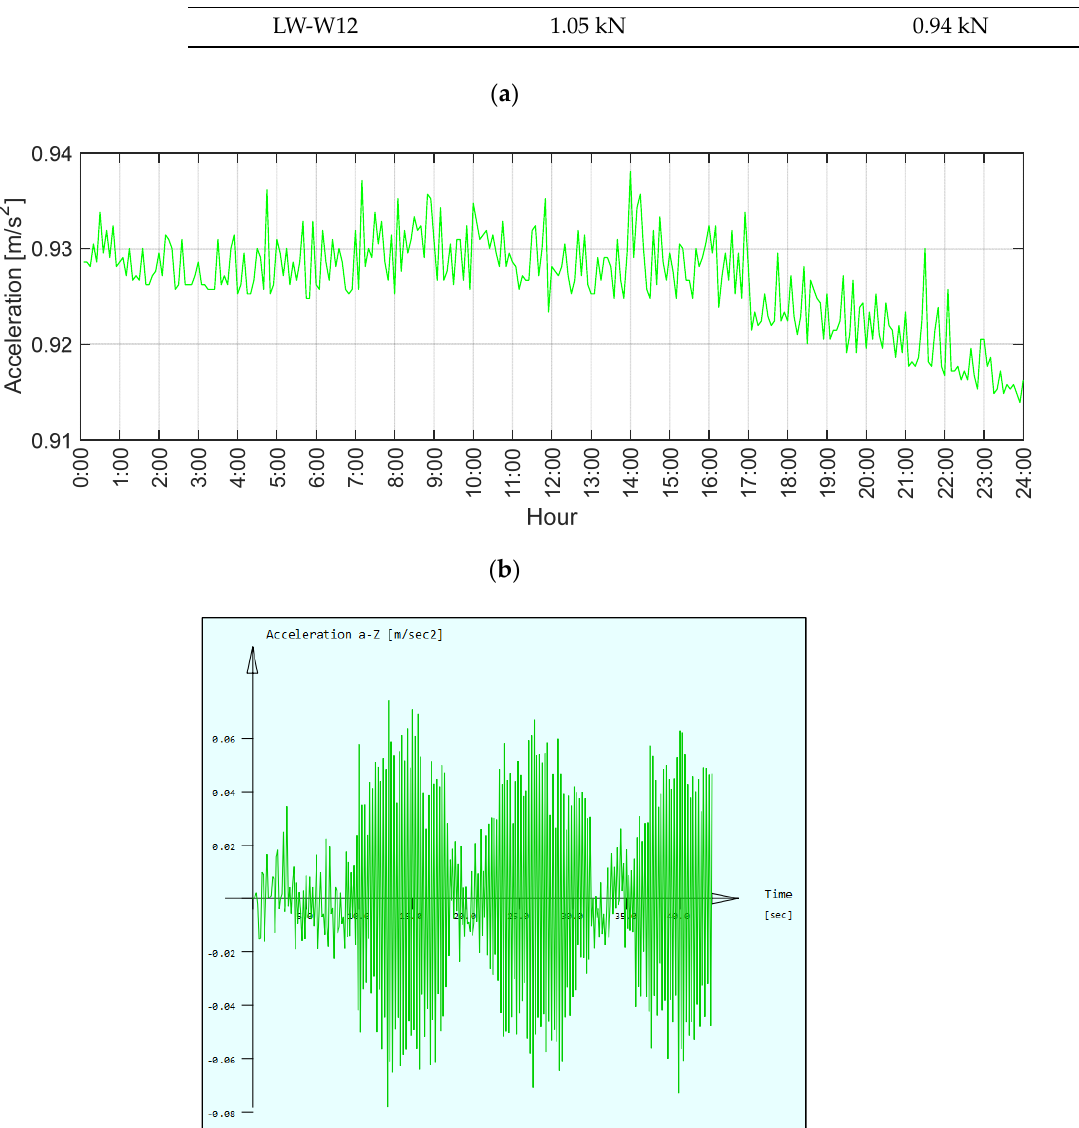
Figure 15. ( a ) Deck accelerations near the cable W-32 anchorages registered by the SHM system; ( b ) vertical acceleration in the middle span deck point (below the cables W-32) during the vehicle crossing.